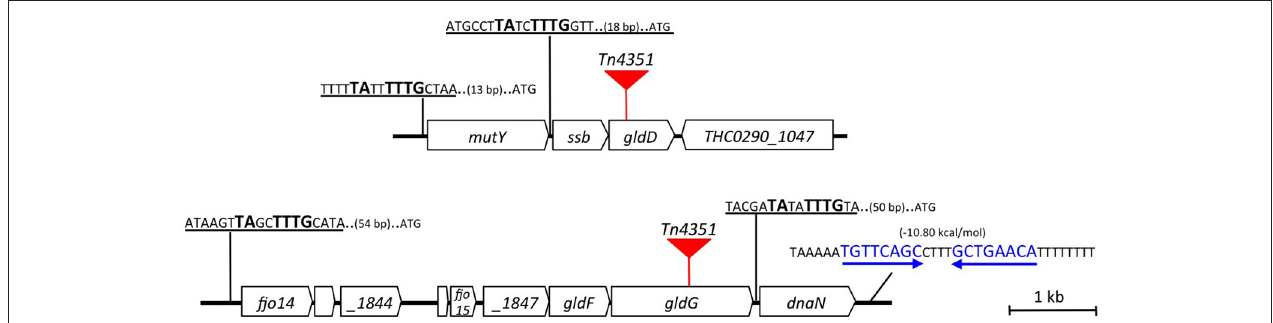
FIGURE 1 | Map of the genetic context of gldD::Tn and gldG::Tn mutants. Red triangles correspond to Tn 4351 insertion in the gldD (upper panel) and gldG (lower panel) genomic regions. Putative promoter sequences are underlined, the consensus sequence of Bacteroidetes promoters (“TAnnTTTG” box) are shown in bold. Putative Rho-independent terminators, shown in blue, were predicted using ARNold finding terminators (http://rna.igmors.u-psud.fr/toolbox/arnold/).